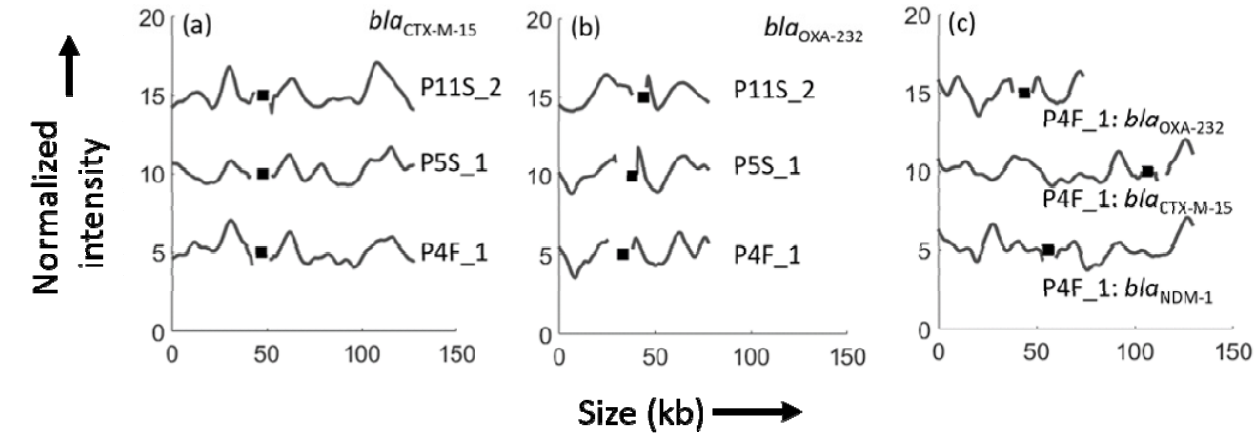
Figure 5. Barcodes of plasmids from three ST16 isolates for ( a ) the bla CTX-M-15 gene. All three isolates show the bla CTX-M-15 gene in a ~128 kb plasmid and the genes (black squares) are in the same location for all three cases. ( b ) The bla OXA-232 gene in the same three isolates showing that the gene is in the same location (black squares) in a plasmid of length ~75 kb. ( c ) Comparison of barcodes showing all three genes, bla NDM-1 , bla CTX-M-15 and bla OXA-232 , (black squares) in isolate P4F_1. The x-axis shows the length of plasmids in kb and the y-axis is the normalized intensity in arbitrary units, where the intensity plot of each isolate is shifted five units vertically for